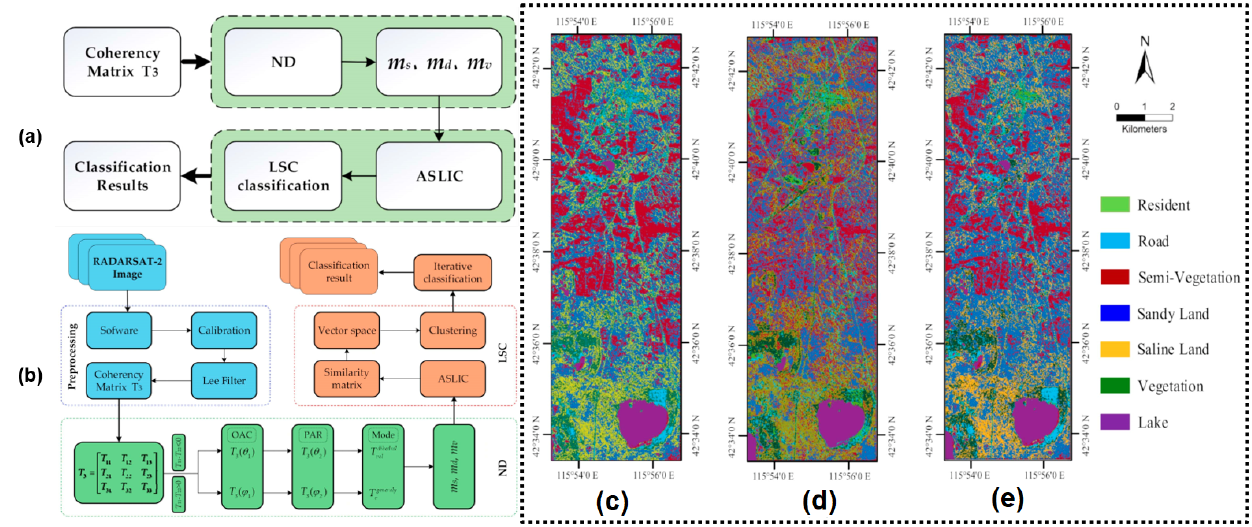
Figure 27. ( Left ) ( a ) The proposed architecture of the work in this paper. ( b ) Flowchart of new decomposition and large-scale spectral clustering with superpixels (ND-LSC) unsupervised classi- fication method. ( Right ) Classification results of three methods in the study area. ( c ) HFED and spectral clustering with superpixels (HED-SC) [298], ( d ) Random Forest Classifier (ND-RF) [299], and ( e ) proposed method (ND-LSC)